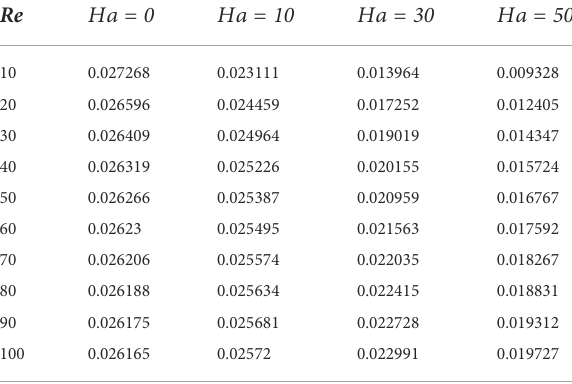
TABLE 4 Kinetic Energy for various values of Re versus Ha, Re (cid:2) 10 , Gr (cid:2) 10 3